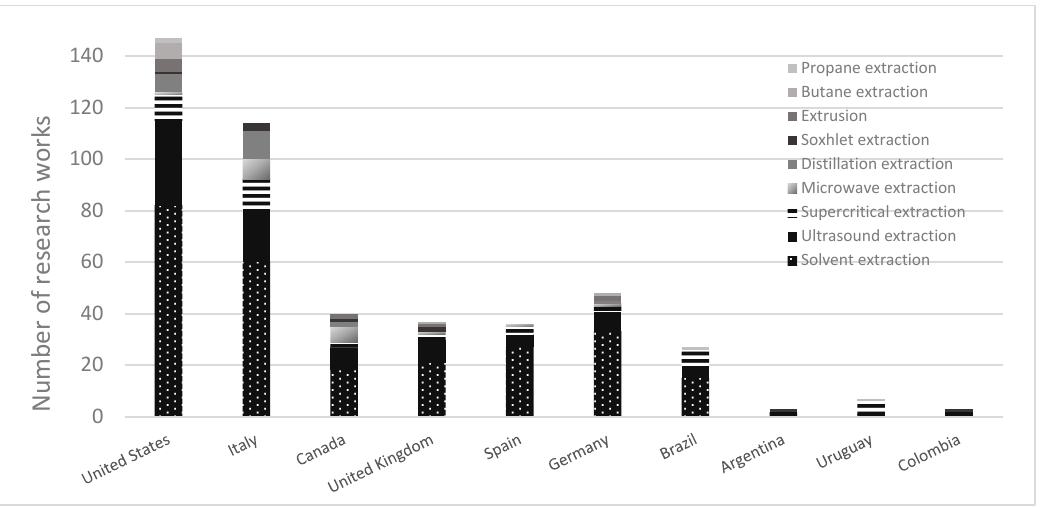
Figure 4. Worldwide publications of cannabinoid extraction technologies.